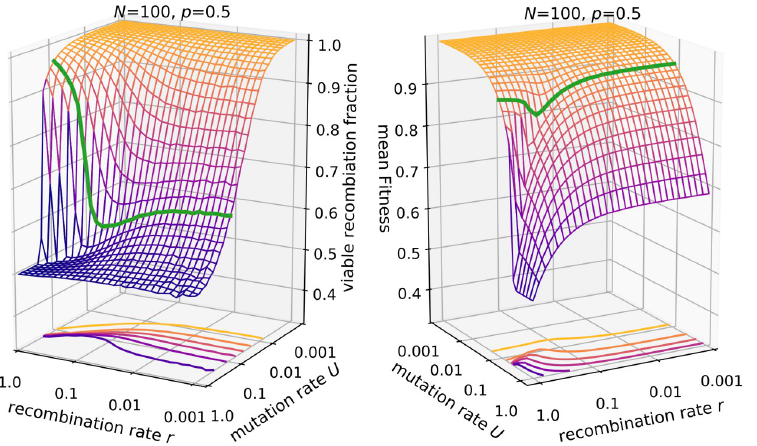
Fig 8. Viable recombination fraction and mean fitness in the ism . Parameters are N = 100, p = 0.5. The green line is drawn at U =